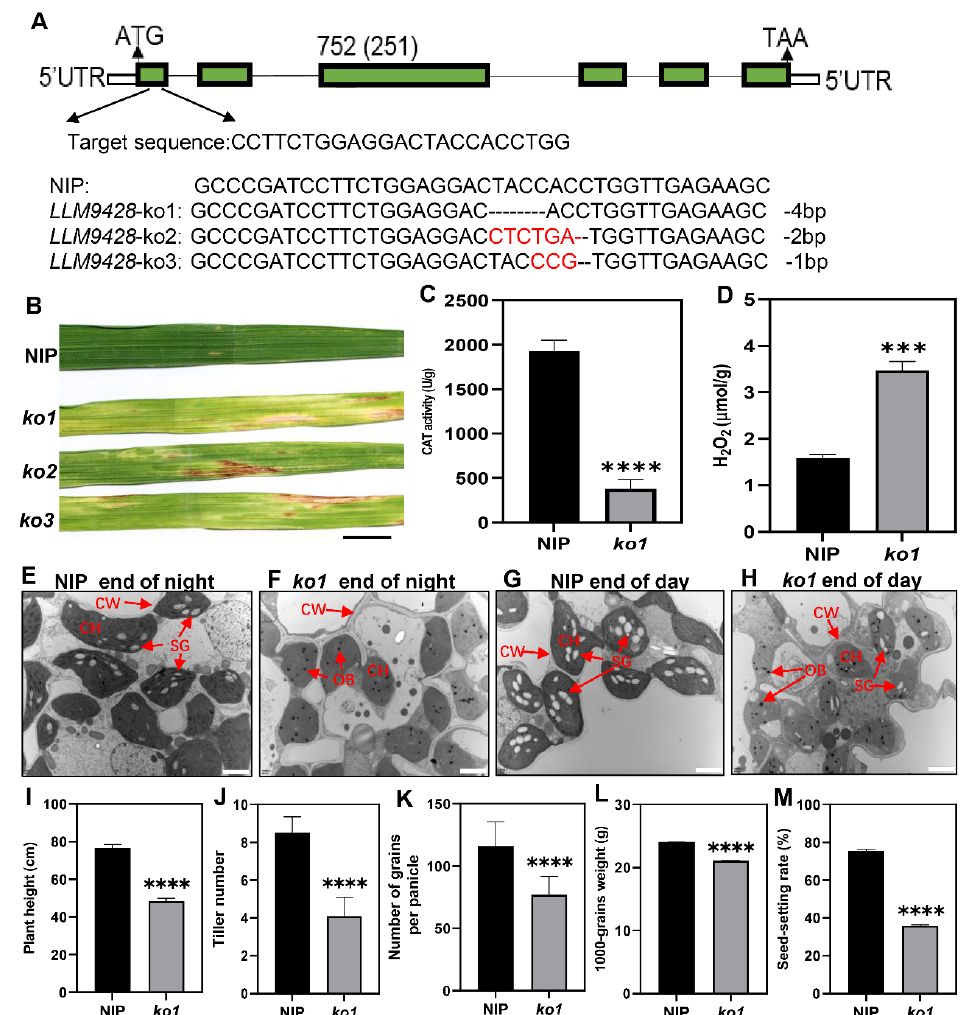
Figure 7. Phenotypic characterizations of knockout lines. ( A ) Deletion of nucleotides through CRISPR/cas9 in ko-1 , ko2 and ko3 , ( B ) The phenotype of KO lines displaying lesion mimic spots on leaves at tillering stage. NIP: Nipponbare. Scale bar: 1 cm. ( C ) Changes of CAT activity in the leaf of NIP and ko1 at the tillering stage, ( D ) Comparison of H 2 O 2 content in the leaves between NIP and ko1 at the tillering stage, ( E ) Sub-cellular structure of leaves in NIP at the end of the night, ( F ) Sub-cellular structure of leaves in ko1 at the end of the night, ( G ) Sub-cellular structure of leaves in NIP at the end of the day, ( H ) Sub-cellular structure of leaves in ko1 at the end of the day, where CW, cell wall, CH, chloroplast; SG, starch granules; OB, osmiophilic body. Scale bar: 2 µ m in ( E – H ). Comparison of agronomic traits e.g plant height ( I ), tiller number ( J ), number of grains per panicle ( K ), 1000-grains weight ( L ), and seed setting rate ( M ). Data were obtained from 10 plants of NIP and ko1 . Statistical analysis was performed using Student’s t -test, where *** indicates p < 0.001 in ( D ) and **** indicates p < 0.0001 in ( C , I – M ). Data presented in ( I – M ) were the average of n = 3